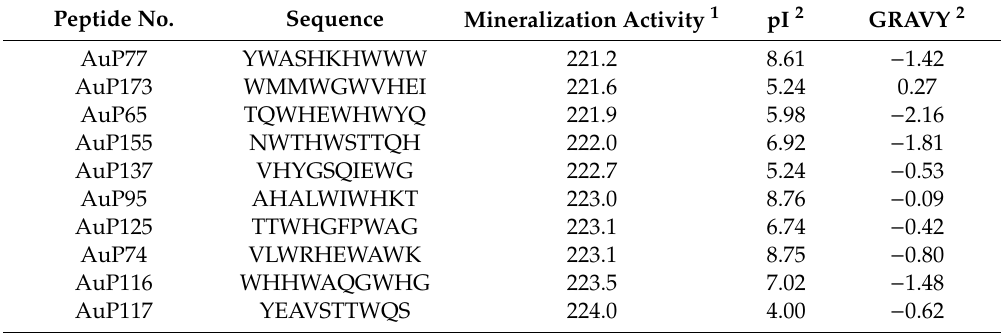
Table 2. List of Ag mineralization peptides (WORST10) screened and their physical properties. Peptide